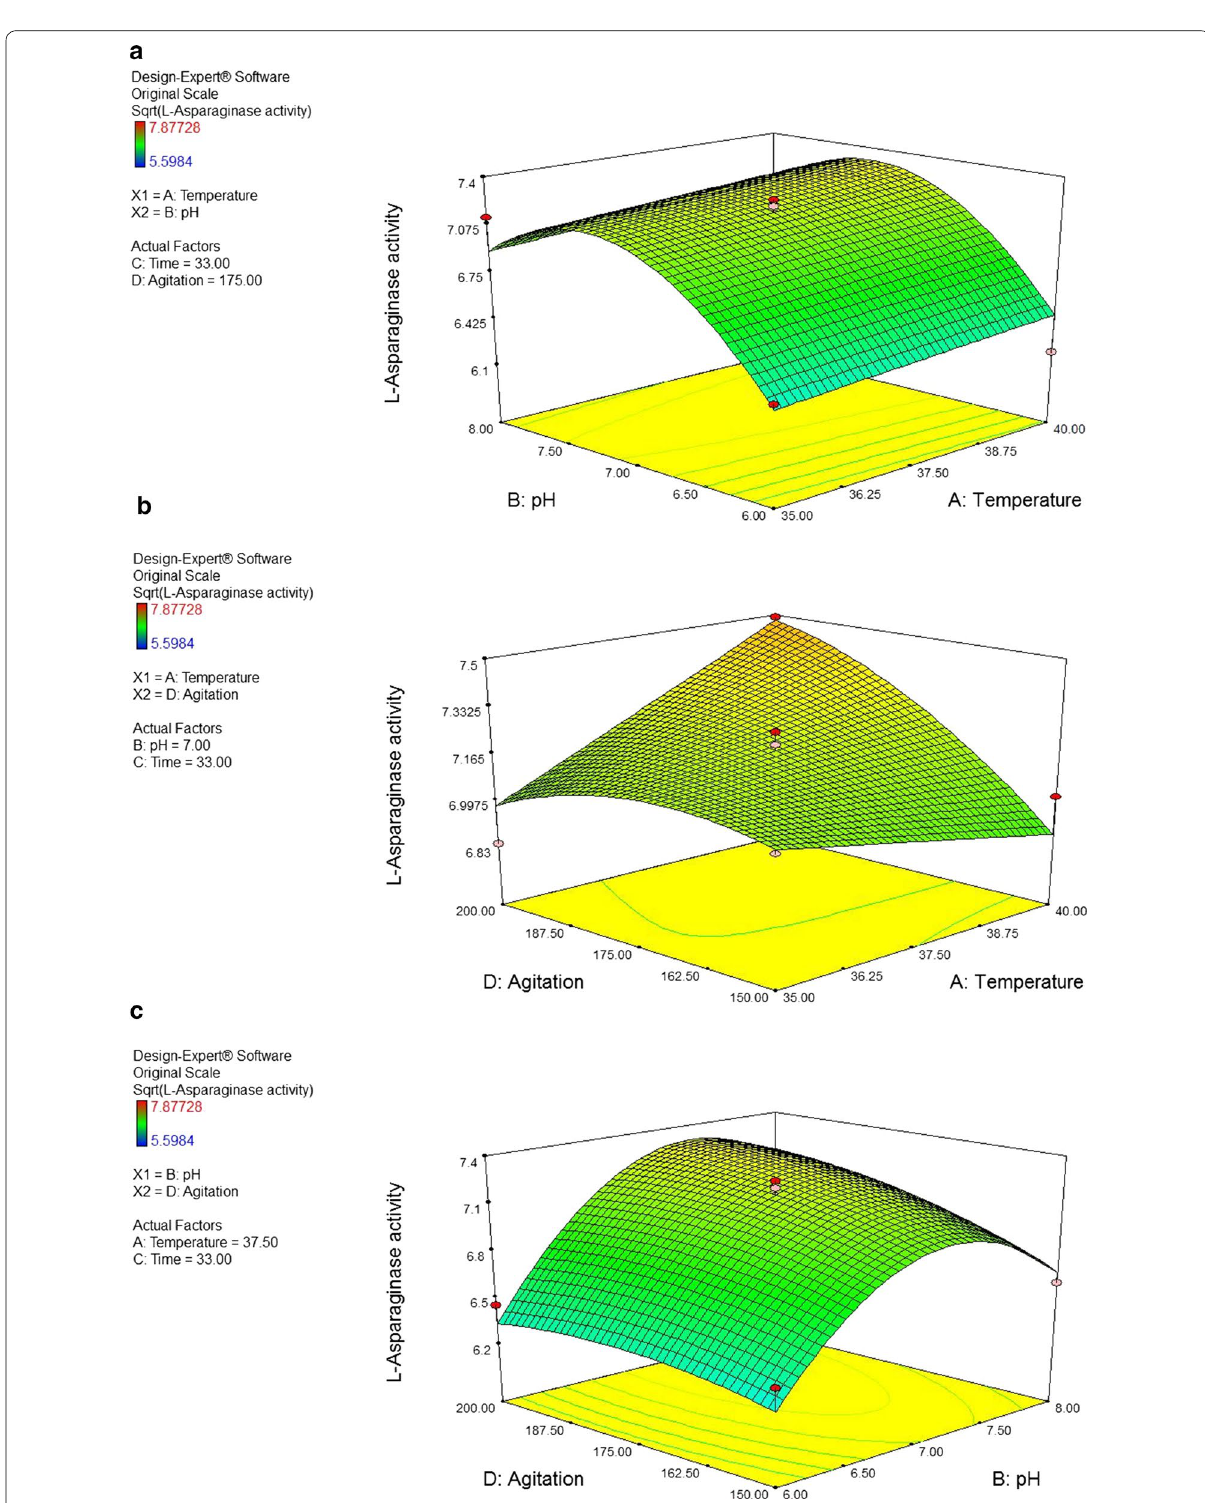
Fig. 5 Response surface plots for the optimization of process parameters showing the effect of a the interaction between temperature (°C) and pH; b the interaction between temperature (°C) and agitation (rpm); c the interaction between pH and agitation (rpm) on l -asparaginase production by Bacillus licheniformis mutant strain. The enzyme productivity was expressed in terms of catalytic